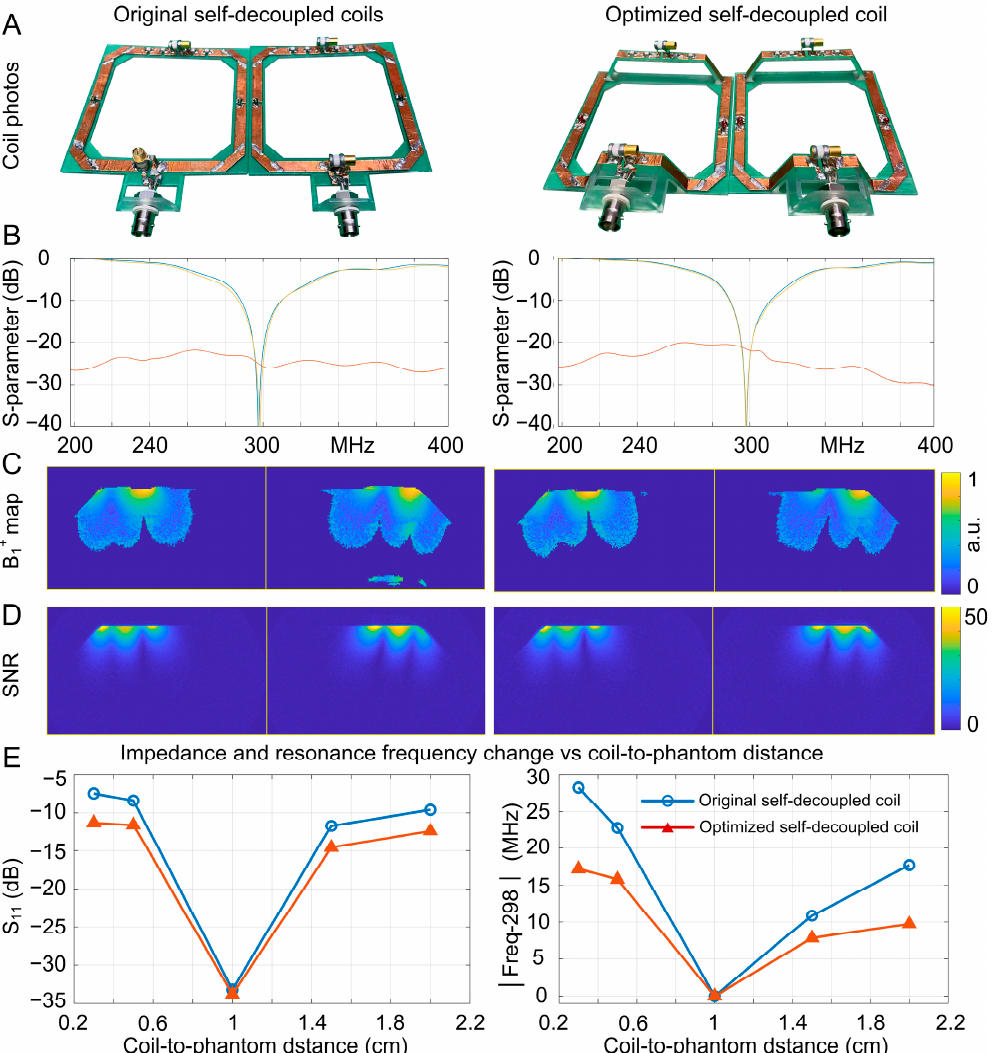
Figure 6. ( A ): Photographs of a pair of original (left) and optimized (right) self-decoupled coils. ( B ): Measured S-parameter plots versus frequency for the two pairs of coils. ( C ): Measured B 1+ maps on the central transverse slice. ( D ): Measured SNR maps on the central transverse slice. ( E ): Measured coil impedance and resonance frequency shift versus different coil-to-phantom distances. Coils were first tuned and matched with a 1 cm separation from the phantom and then moved closer or further away from the phantom with no retuning or rematching.